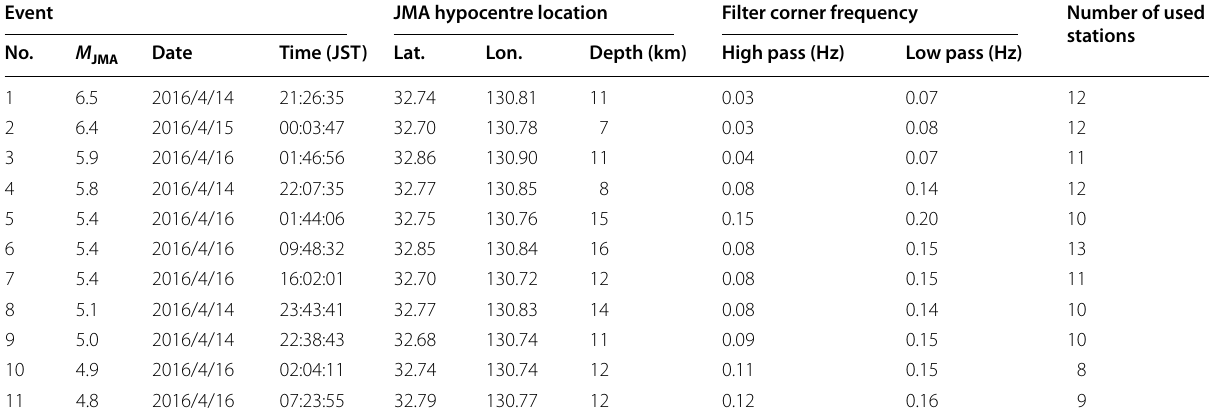
Table 1 List of processed earthquakes from the Kumamoto